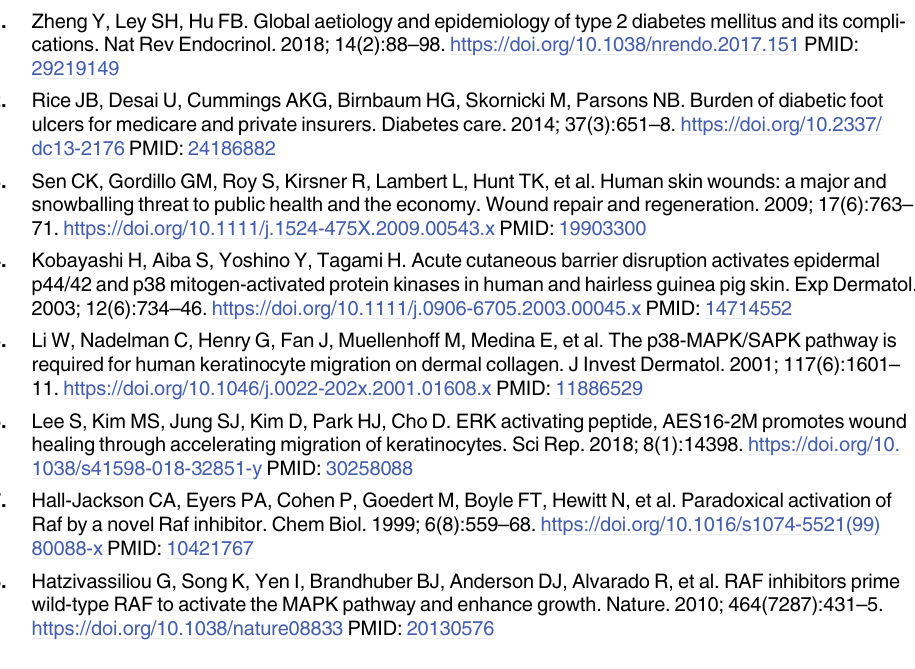
S1 Table. Full list of genes differentially expressed by 1.5-fold or more in either the vemur- afenib-treated or control wounds on day 16. (A) normalized gene expression, (B) differential expression between the vemurafenib-treated and control wounds on day 16, and (C, D, E, F, G) ENRICHR-based enrichment analysis in the respective gene sets/gene ontology/pathway on genes with at least 1.5-fold expression change in Table